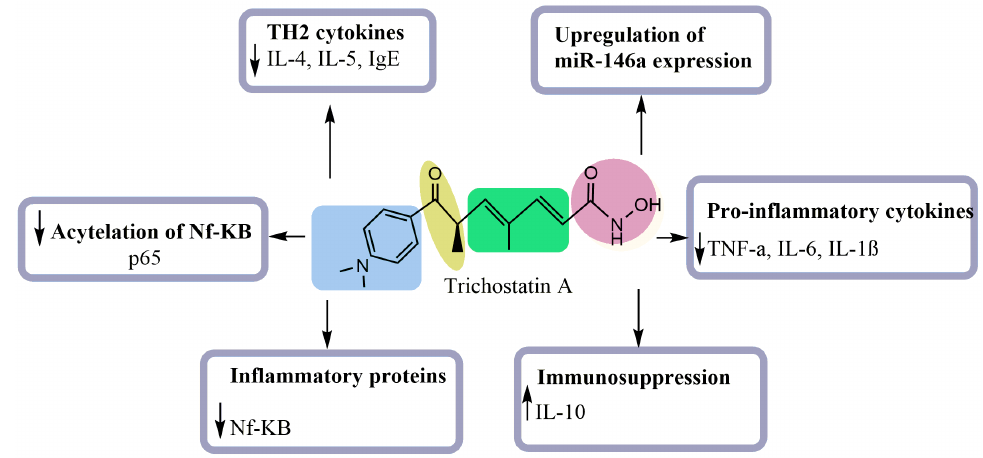
Figure 4. Anti-inflammatory mechanisms of TSA Table 3. Anti-inflammatory effects of Trichostatin A.